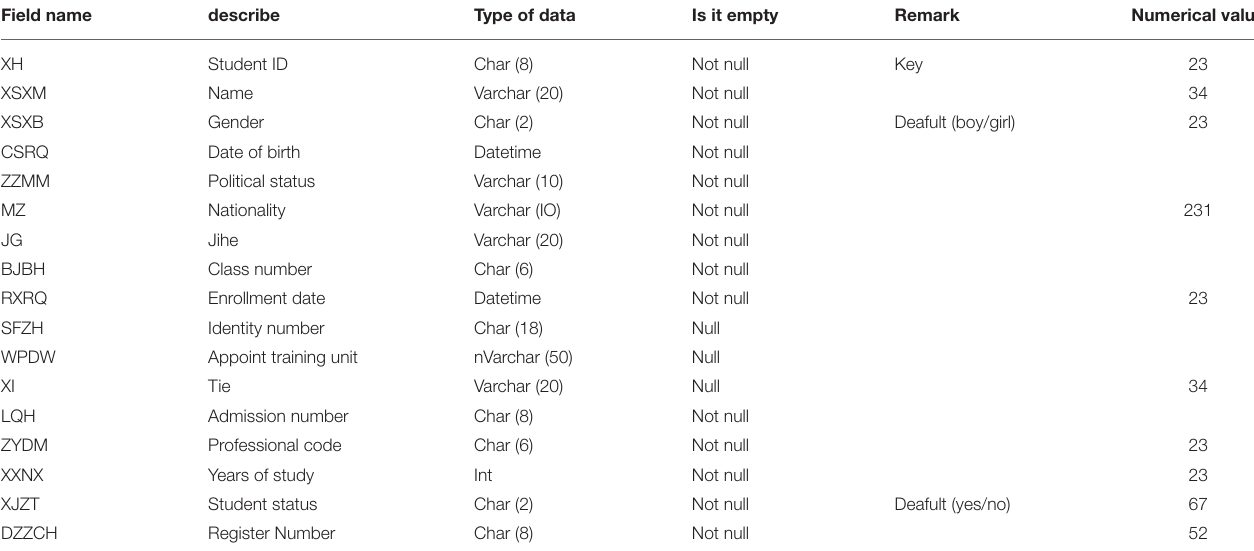
TABLE 1 | Students basic information table.